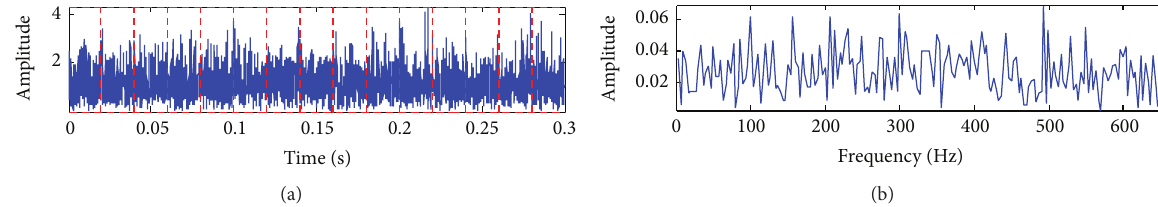
Figure 3: Analyzed results of simulated signal shown in Figure 2(b) by Hilbert transform: (a) envelope waveform; (b) envelope spectrum.